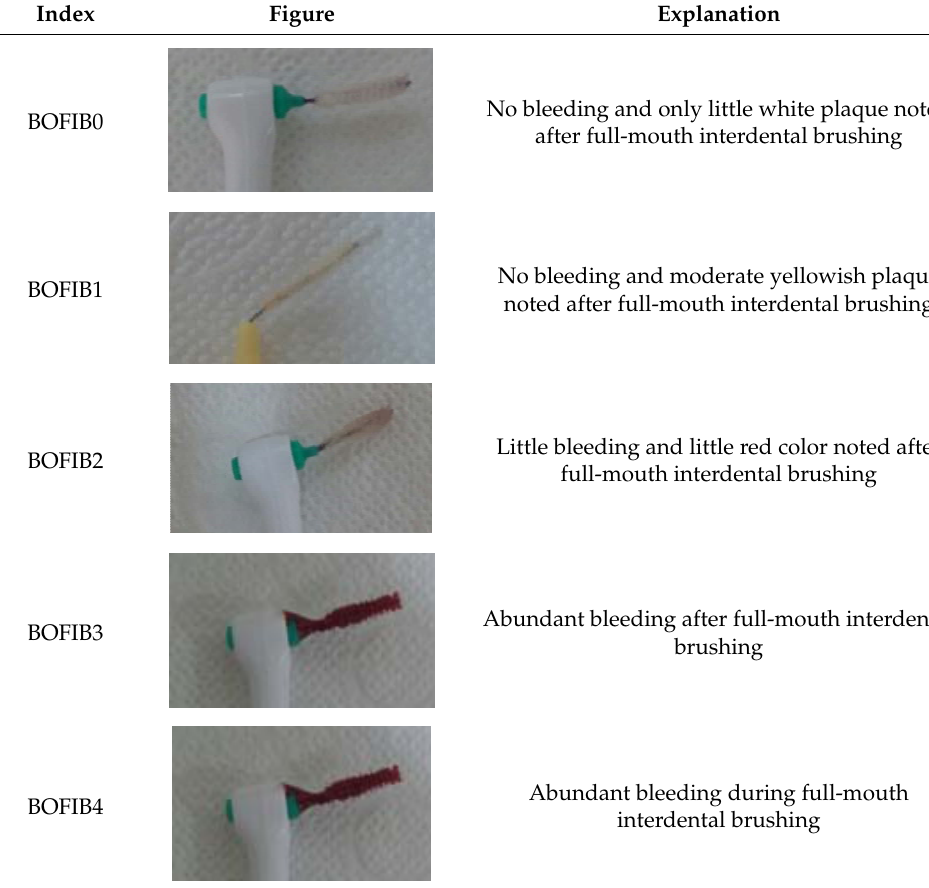
Table 2 . Bleeding on the full-mouth interdental brush (BOFIB) index.